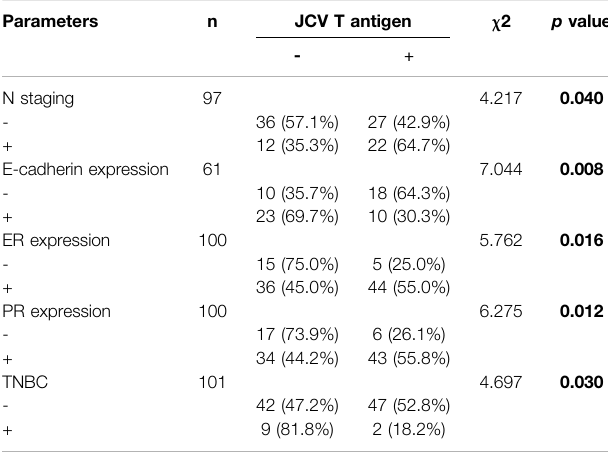
TABLE 1 | The correlation between JCV T antigen existence and clinicopathological features of breast cancer. Parameters